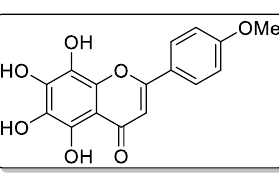
Figure 11. This is chemical formula of the compound 5 (Figure 6).